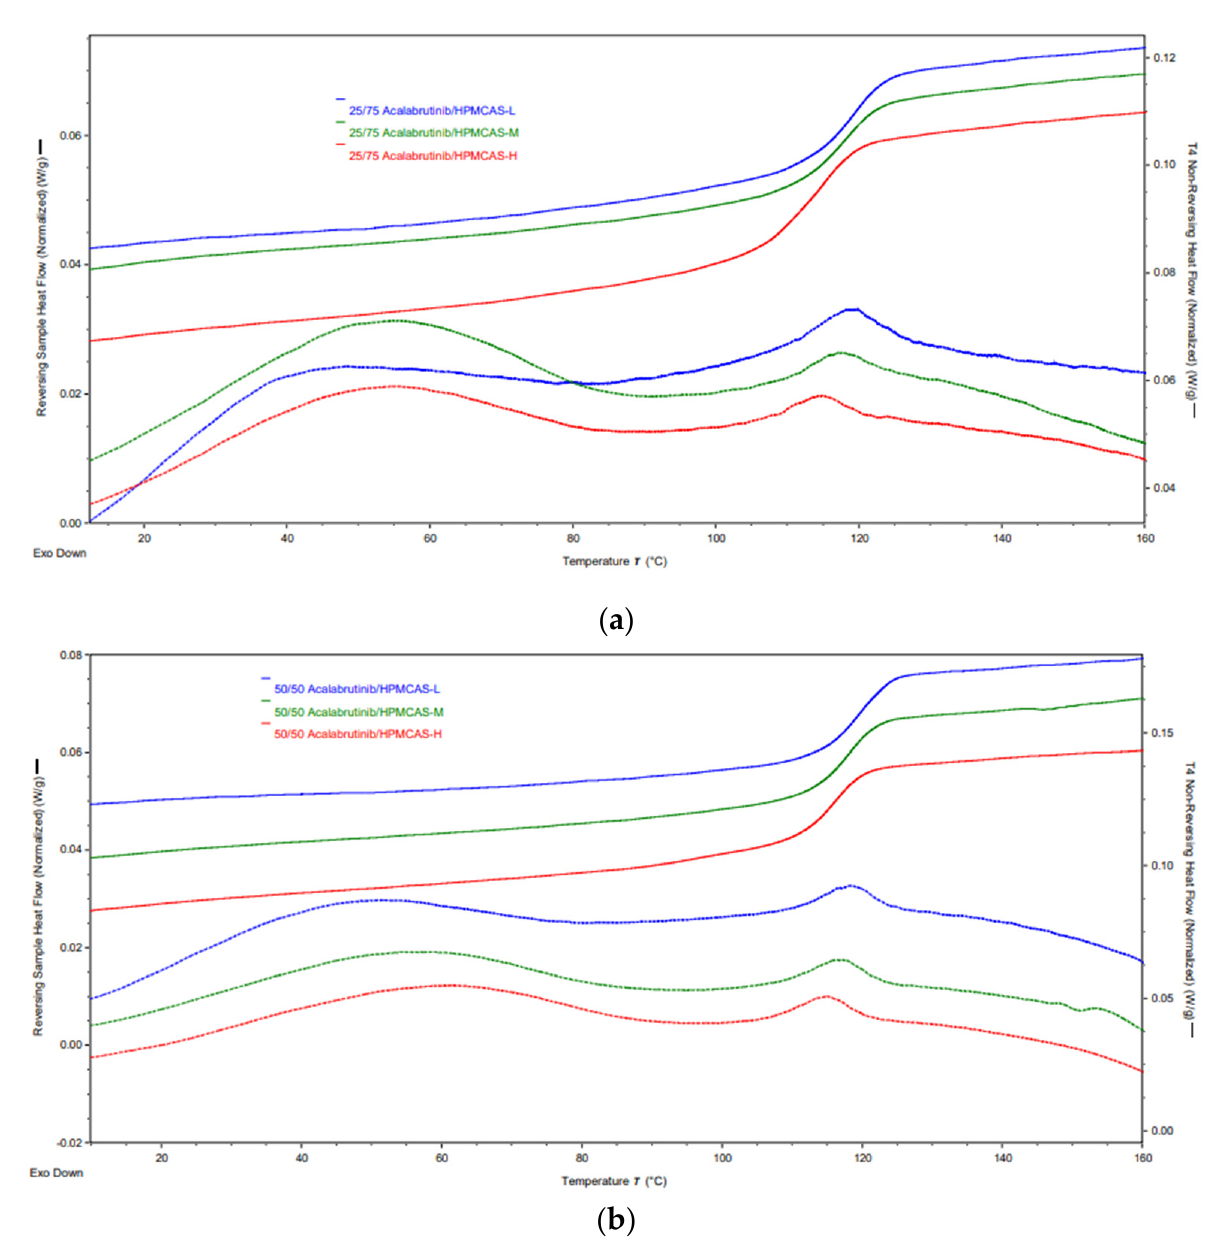
Figure A4. Powder X-ray diffractograms of manufactured acalabrutinib ASDs in comparison to